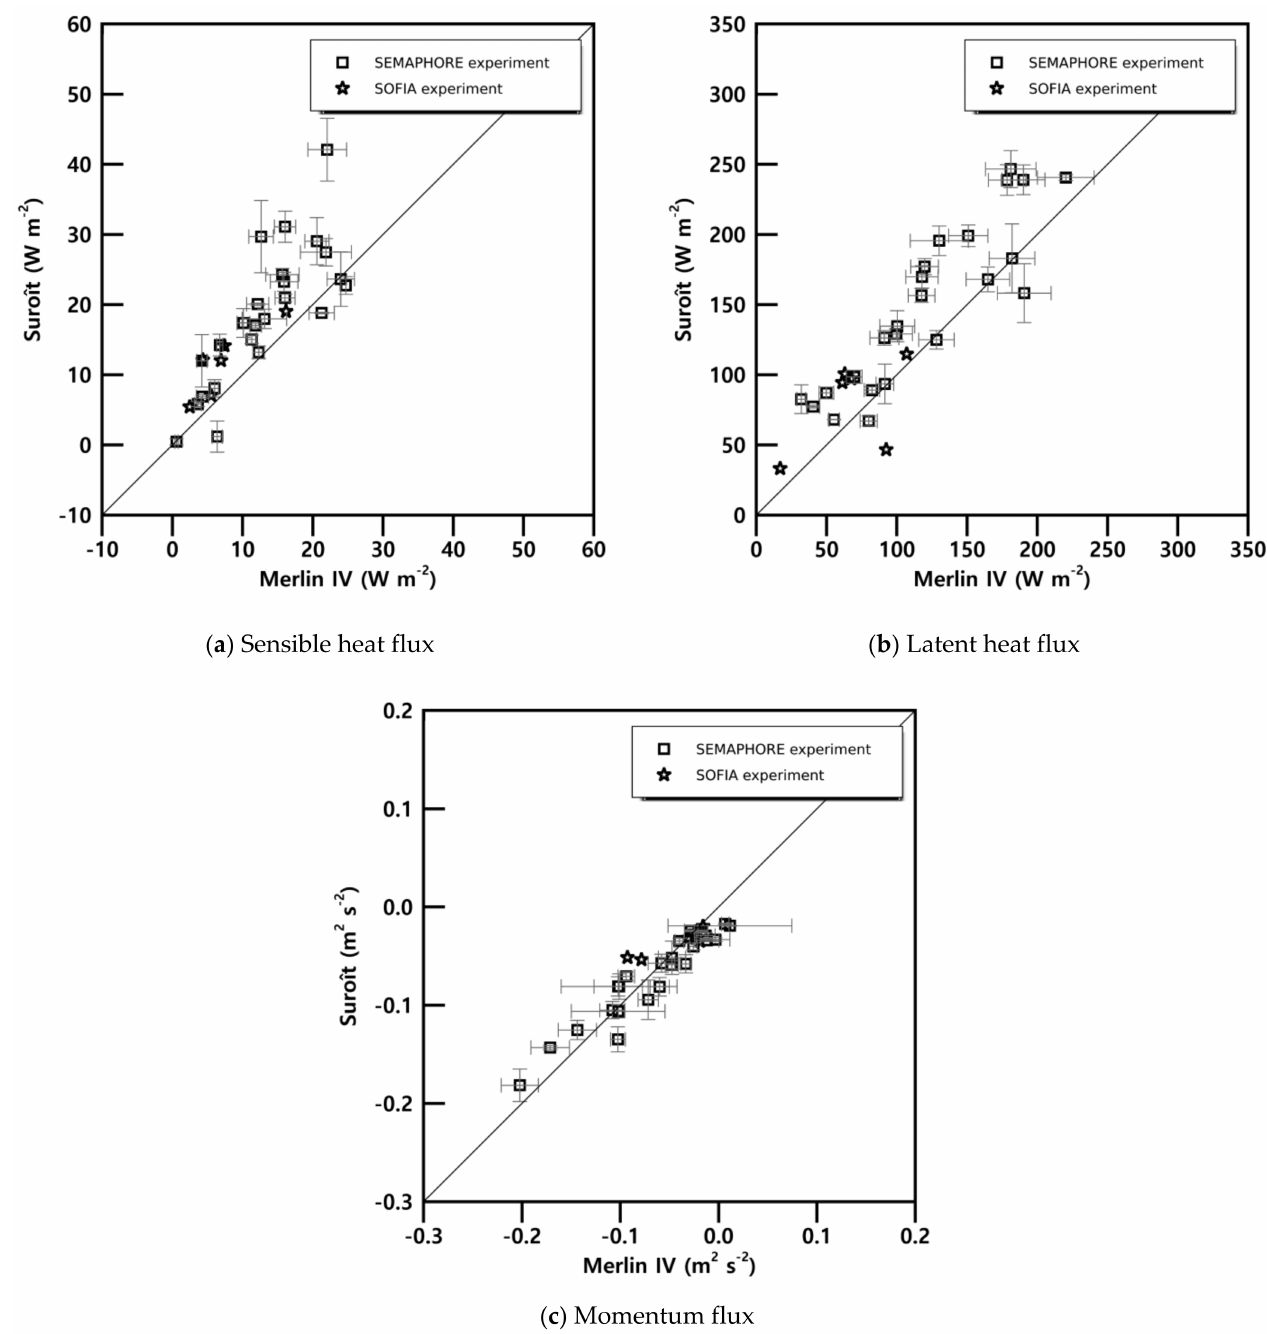
Figure 10. Comparison of ( a ) sensible heat fluxes, ( b ) latent heat fluxes and ( c ) momentum fluxes between the ship and the